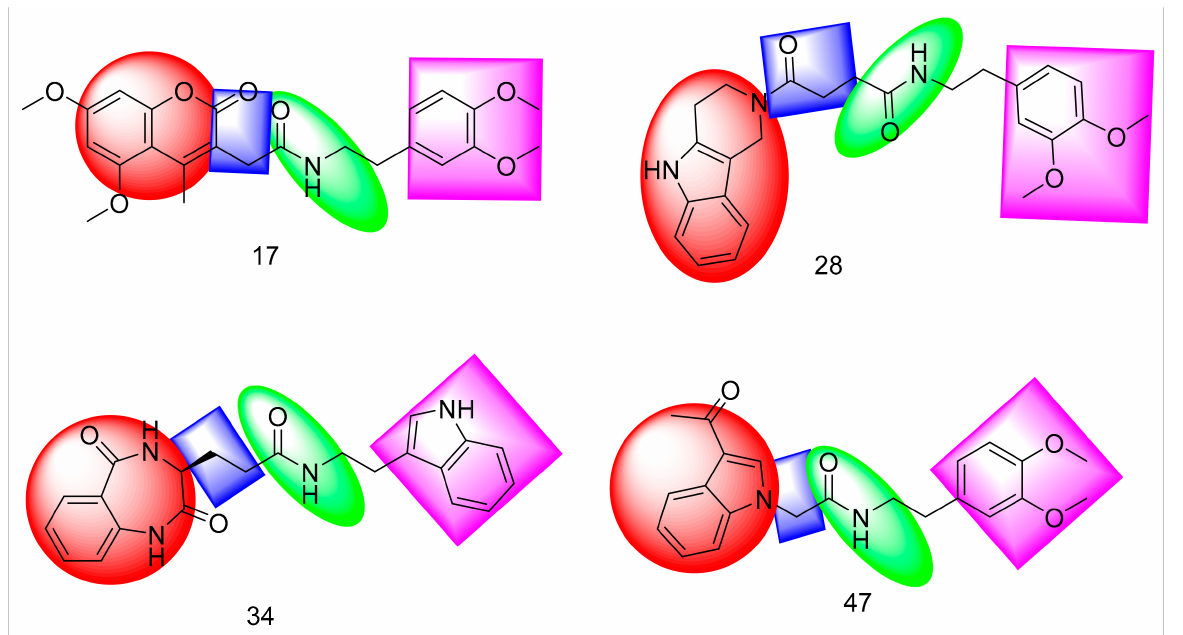
Figure 3. Representative sample of the examined semi-synthesized molecules having the main features of PLPIs.